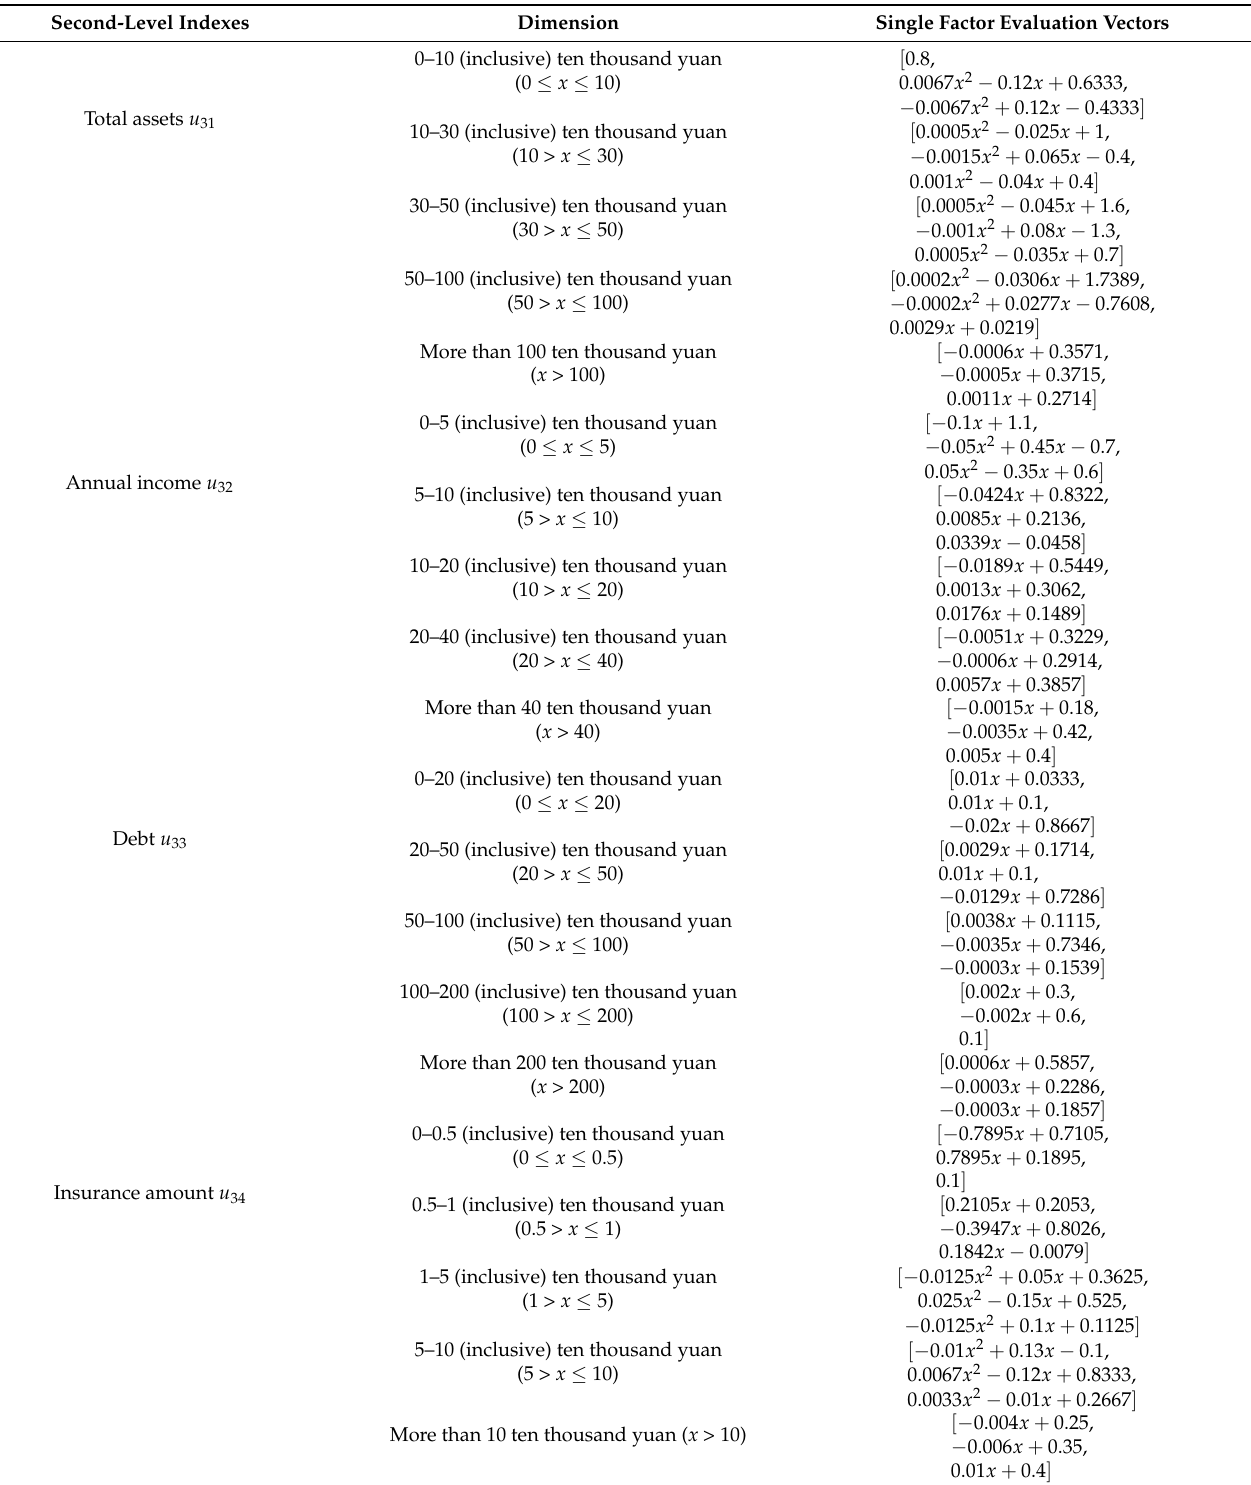
Table 11. Single factor evaluation of economic situation